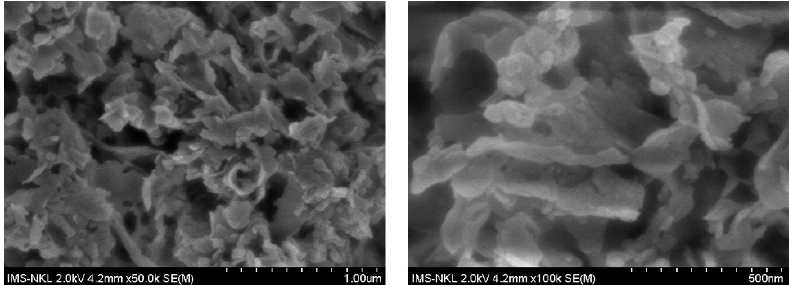
Figure 4. Field emission scanning electron microscopy (FE-SEM) images of pure g-C 3 N 4 nanosheets with different magnifications.